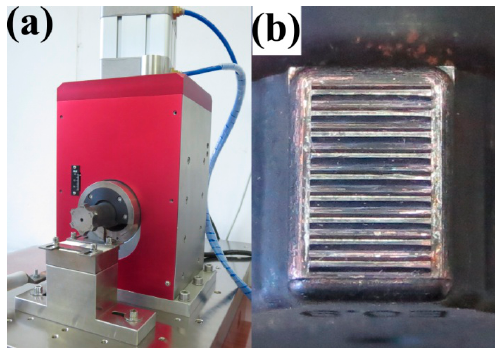
Figure 1. ( a ) USW system employed in the study; ( b ) sonotrode tip.